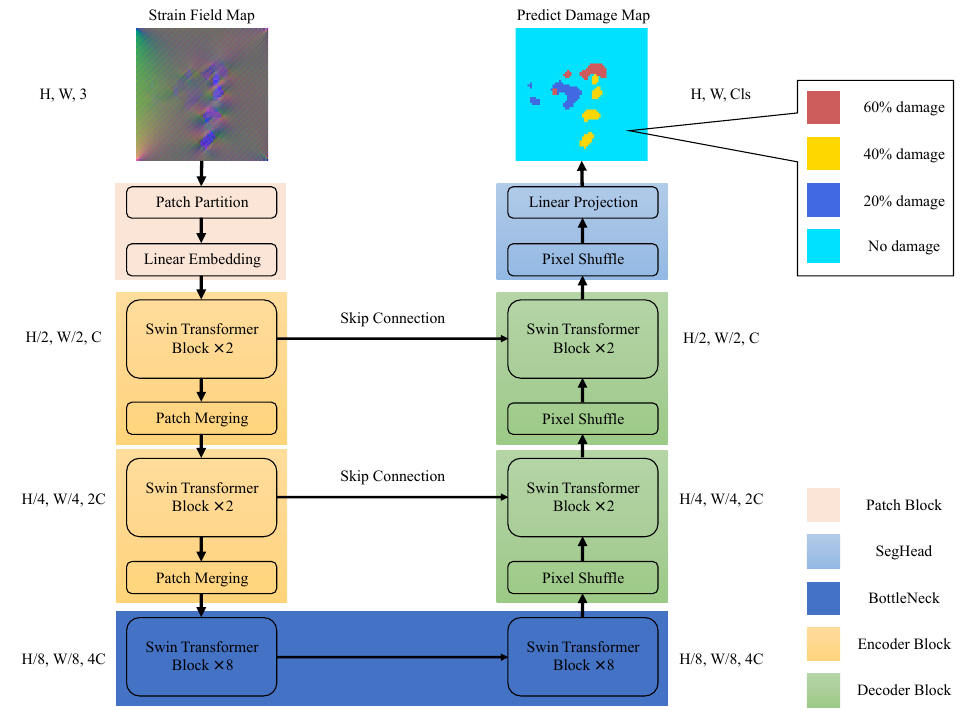
Figure 2. Overview of SDFormer network